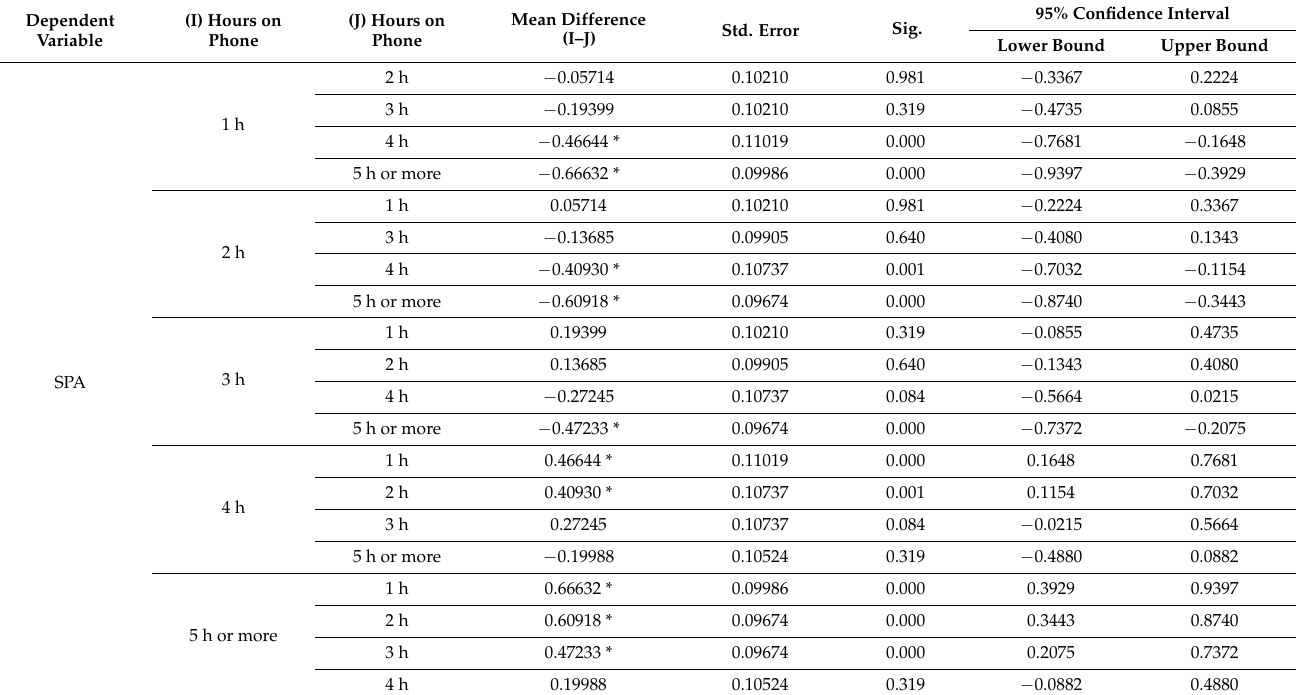
Table 19. Multiple comparisons analysis of the SPA attributed to the number of hours on the smartphone using Tukey